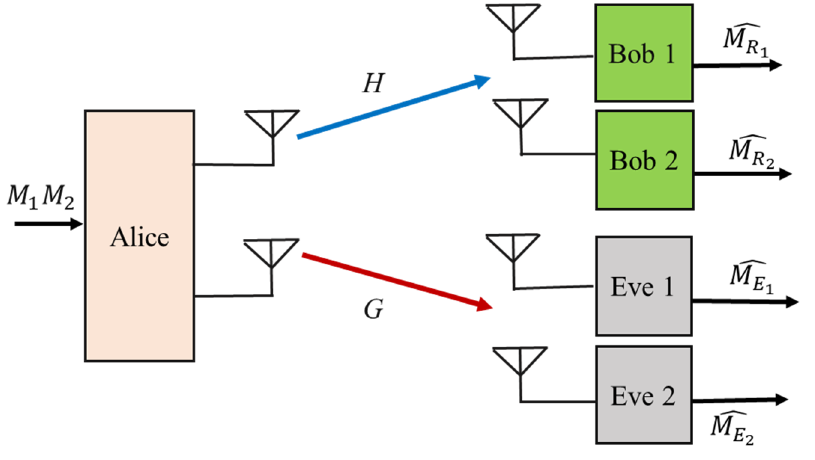
Figure 3. A system model for a broadcast wiretap channel.